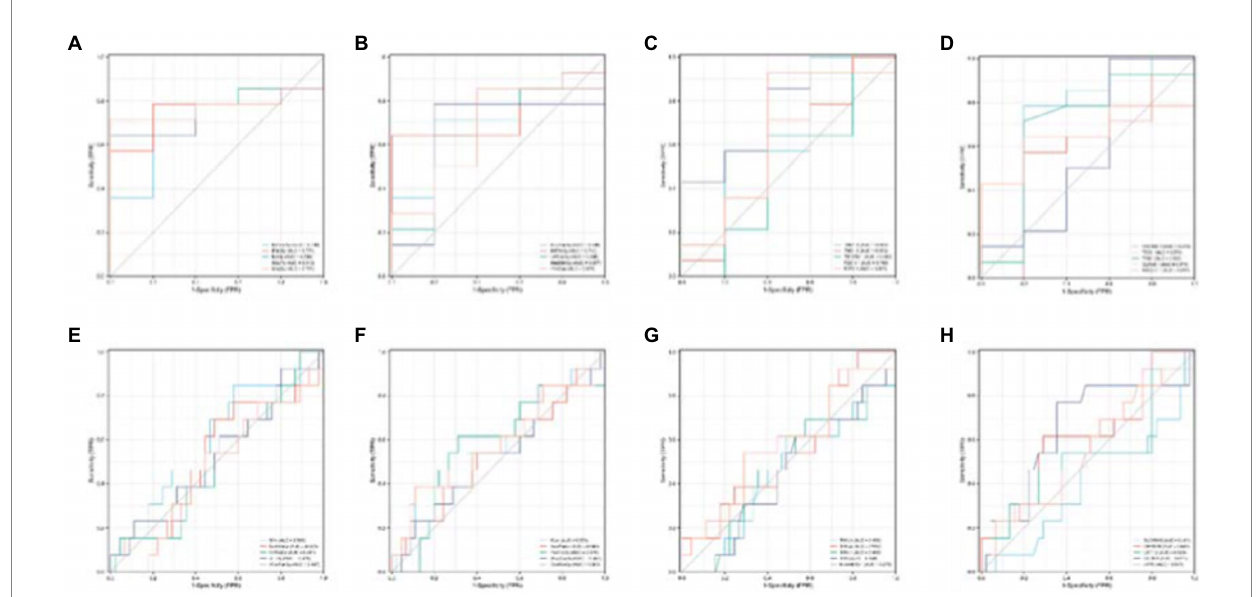
FIGURE 13 Single validation of Top 10 ROIs and genes for the two groups. (A–D) Are the ROC curves of the first five and last five ROIs of the AD group, respectively. (E–H) Are the ROC curves of the first five and last five ROIs of the MCI